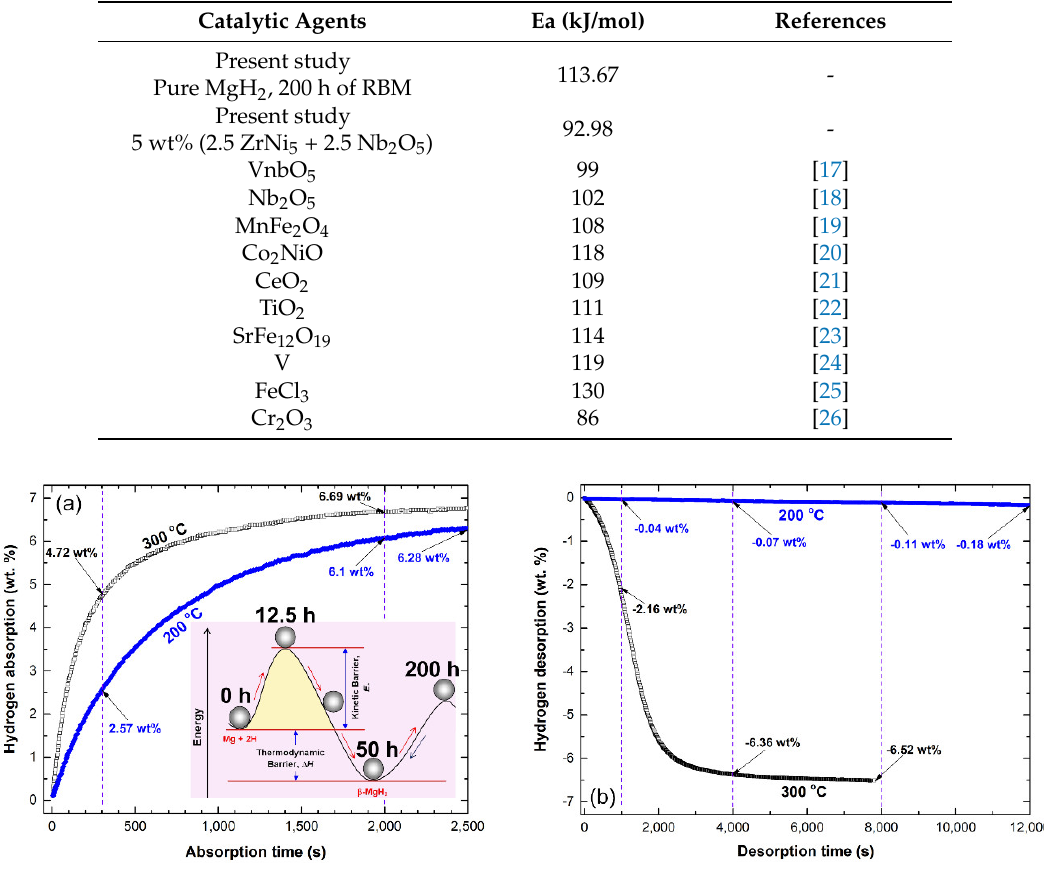
Figure 7. Kinetics of ( a ) hydrogenation and ( b ) dehydrogenation for pure MgH 2 nanocrystalline powders obtained after 200 h of RBM time. The measurements were conducted under hydrogen pressure of 10bar and 200 mbar, respectively.